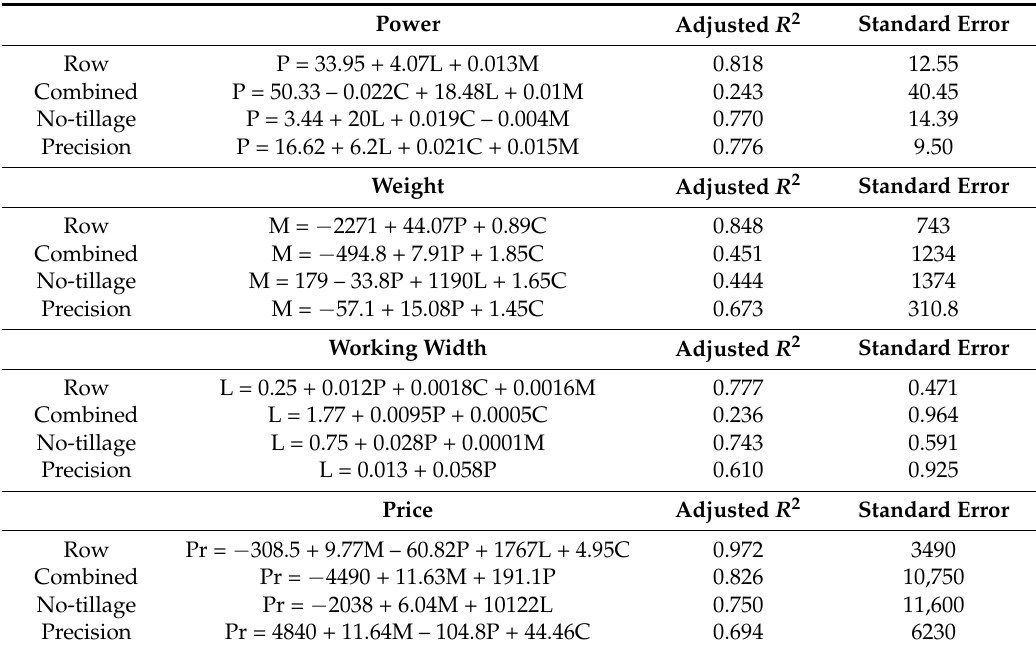
Table 11. Equation models for response variables (power, weight, working width, price) determined by stepwise regression analysis (C—tank capacity, L; M—weight, kg; P—power, kW; L—working width, m; Pr—estimated price for different groups of machines, €